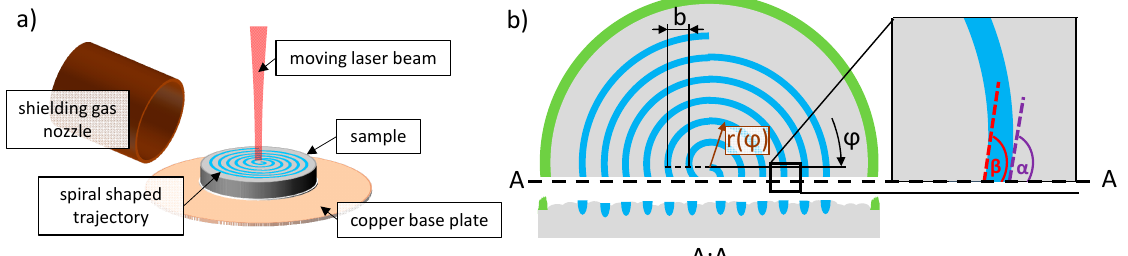
Figure 3. ( a ) Mounting of the samples in the experimental setup. The shielding gas nozzle was used to supply nitrogen to minimize oxidation. The laser beam was moved along a spiral-shaped trajectory by means of a scanner, ( b ) top view of a processed sample. A:A shows the plane of the cross-section. The detail shows the angles α and β that were considered for the evaluation when the cross-sections were not exactly centered to the origin of the spiral